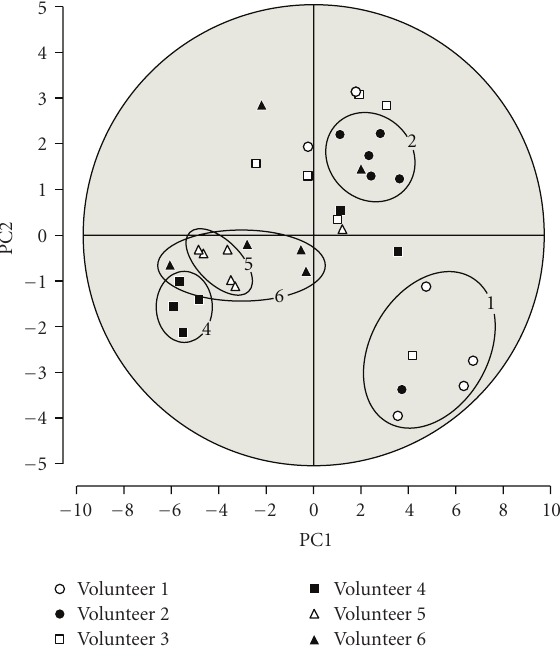
Figure 5: Principal component analysis of spot maps originating from di ff erent volunteers. Spot maps of the same volunteer to a certain extent cluster